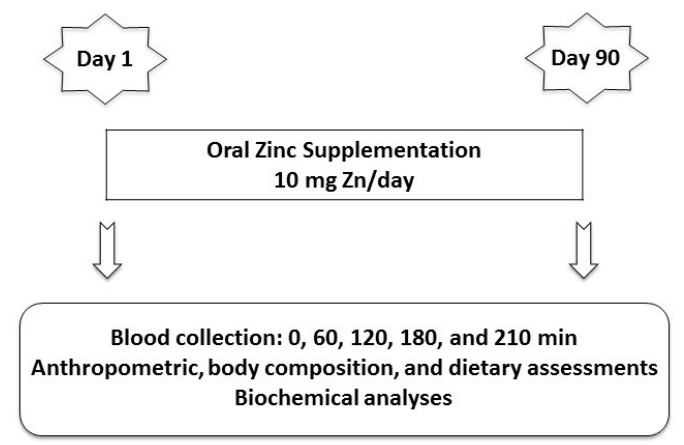
Figure 1. Experimental design of oral zinc administration in the control and experimental